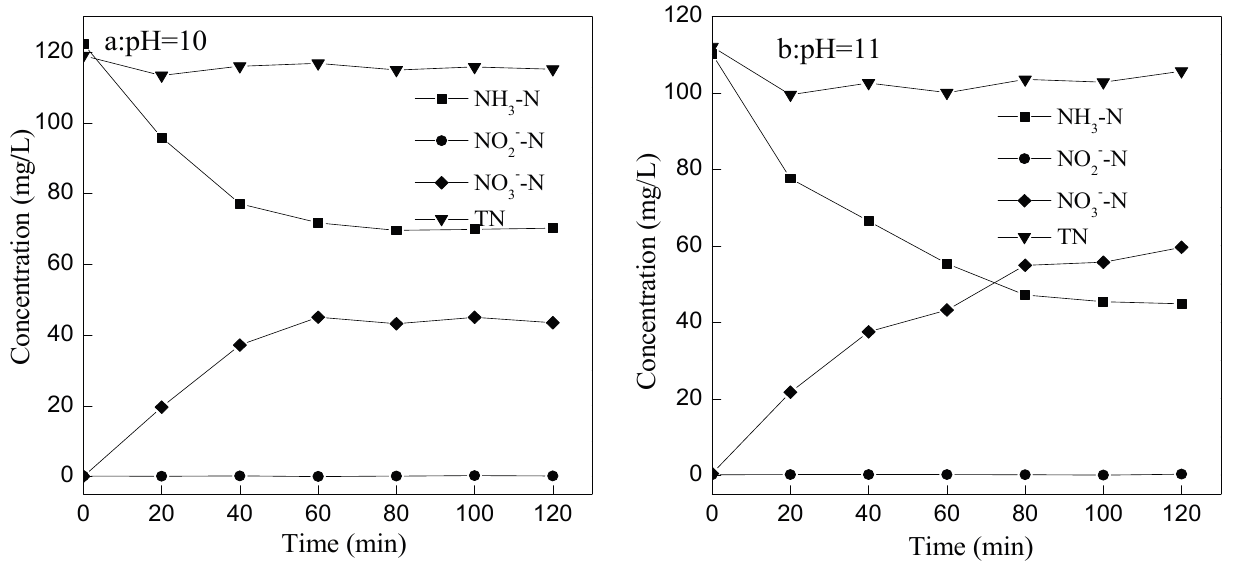
Figure 7. The concentration changes of NH 4+ -N, TN, NO 3 -N, and NO 2 − -N with time. ( a ) At pH 10; ( b ) At pH